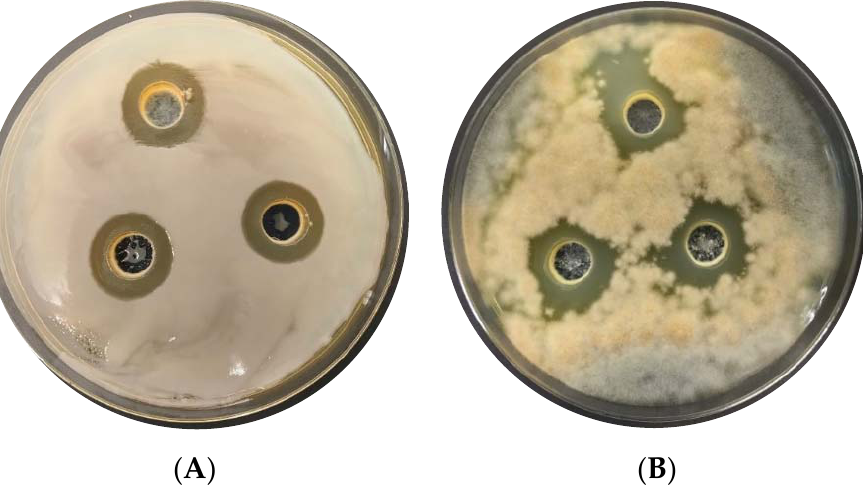
Figure 5. Growth inhibition zones of P. carotovorum ( A ) and A. solani ( B ) by L. plantarum KB2 LAB 03 cultured on an A100 M100 acid whey ‐ based medium.